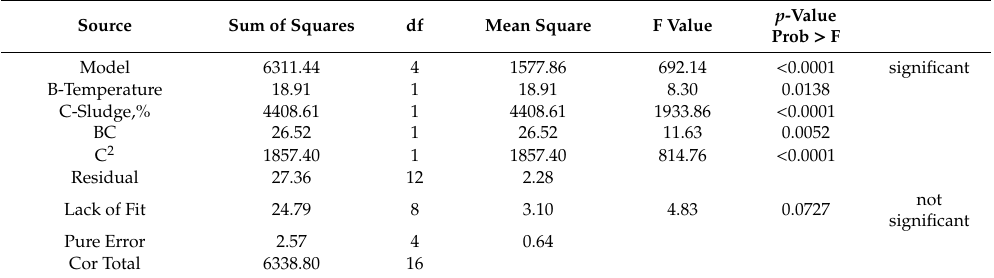
Table 13. ANOVA table for CH 4 % for AD of pot ale quadratic model α =